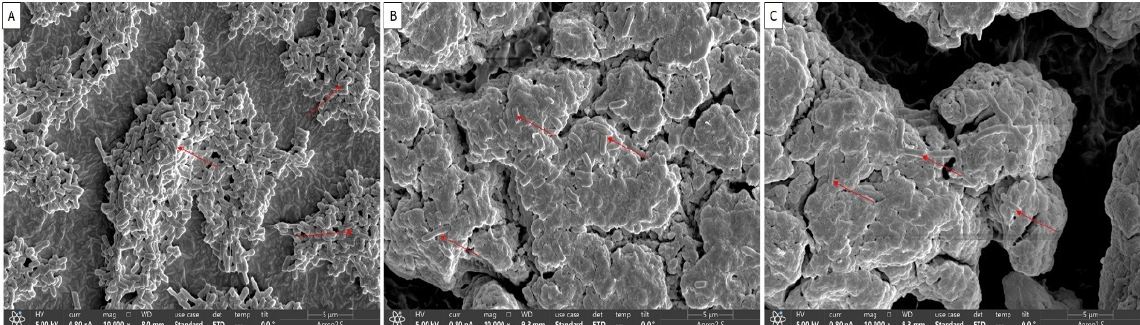
Figure 6. Representative scanning electron micrographs of V. parahaemolyticus biofilms formation in the presence of sub-MICs of quercetin on the hand glove surfaces: ( A ) Control (0% quercetin); ( B ) 1/4 MIC; ( C ) 1/2 MIC.